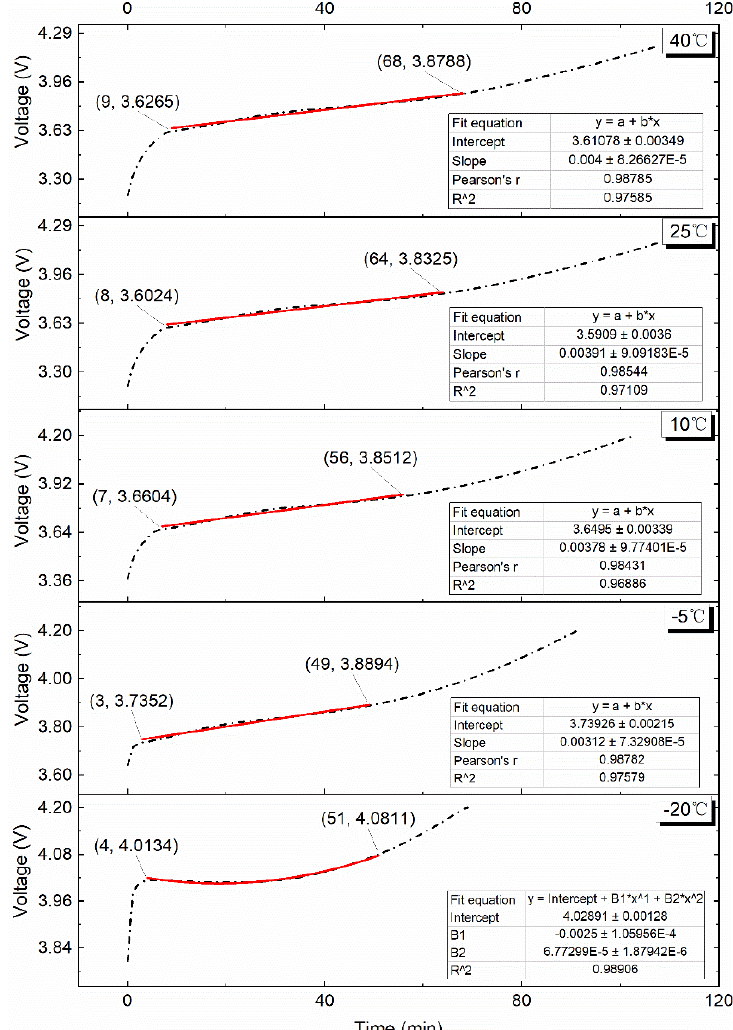
Figure 11. Effect of various temperatures on the VPP at 0.50C charging.